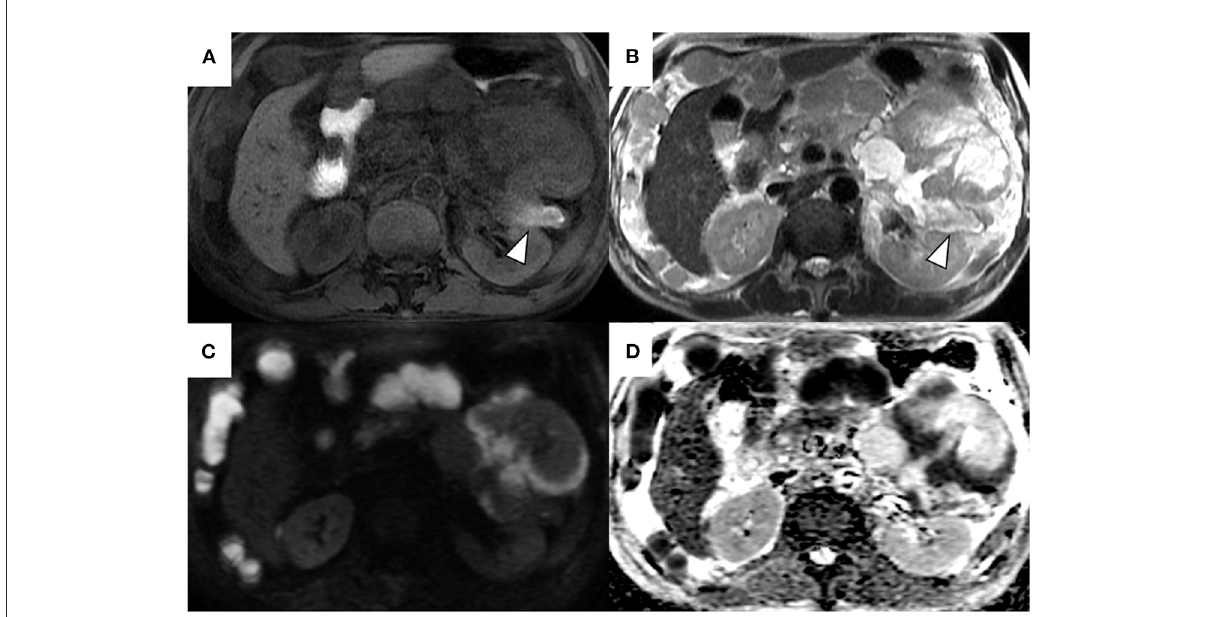
FIGURE3 Magnetic resonance T1-weighted image (A) , T2-weighted image (B) , diffusion-weighted image (C) , and apparent diffusion coefficient map (D) . T2-weighted images show a heterogeneous and hyperintense mass in the pancreatic tail (B). The area corresponding to solid components on computed tomography shows hyperintensity on diffusion-weighted images with a b factor of 800 s/mm2 and hypointensity on the apparent diffusion coefficient map (C,D) . The signal intensity of the main pancreatic duct in the tail was high on T1-weighted image and low on the T2-weighted image (arrowheads).